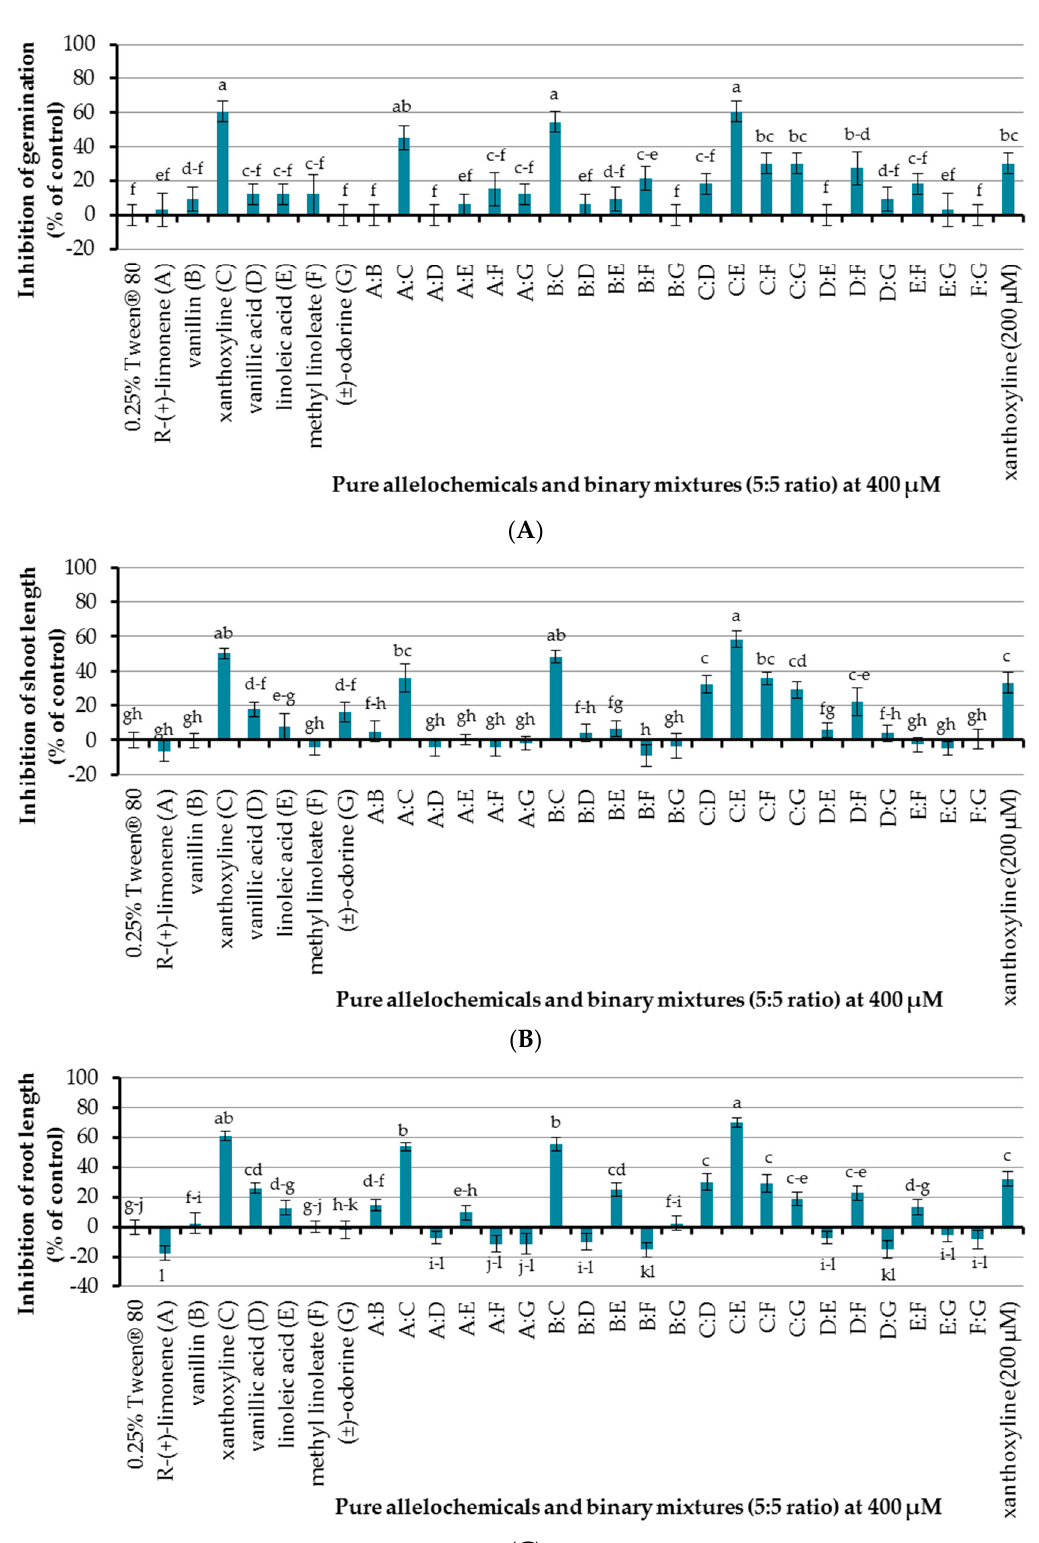
Figure 3. Inhibitory effects of seven allelochemicals and their binary mixtures (at 400 μ M) on seed germination ( A ) and shoot ( B ) and root ( C ) growth of Chinese amaranth. A 0.25% aqueous solution of Tween ® 80 was used as a control. Means with the same letters in each graph are not significantly different at p ≤ 0.05 level.